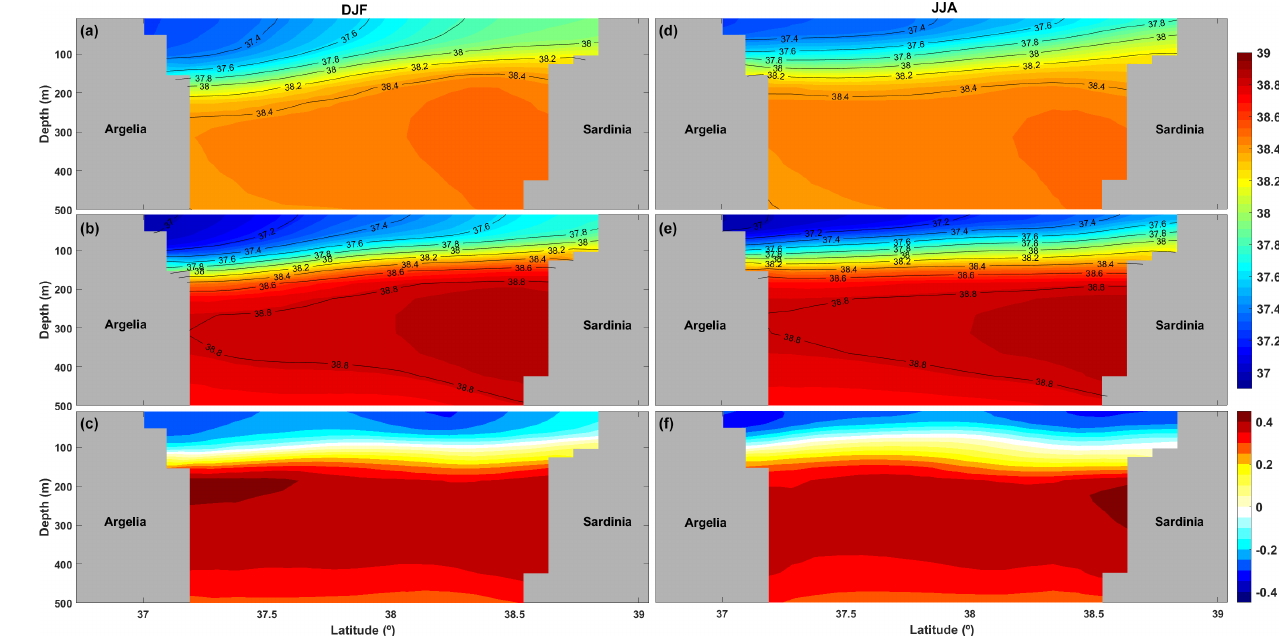
Figure 8. Winter (a–c) and summer (d–f) vertical cross sections of salinity, in psu, through the Sardinia Strait for present (a, d) and future (b, e) climate as computed from ROM. Isohalines are shown. Differences between ocean salinity in the future and present climate are presented in panels (c) and (f) .